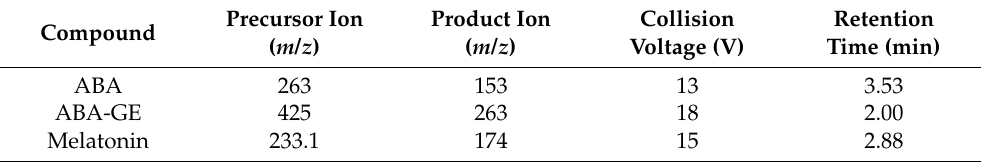
Table 3. Optimized MS/MS settings and retention time with the chromatography